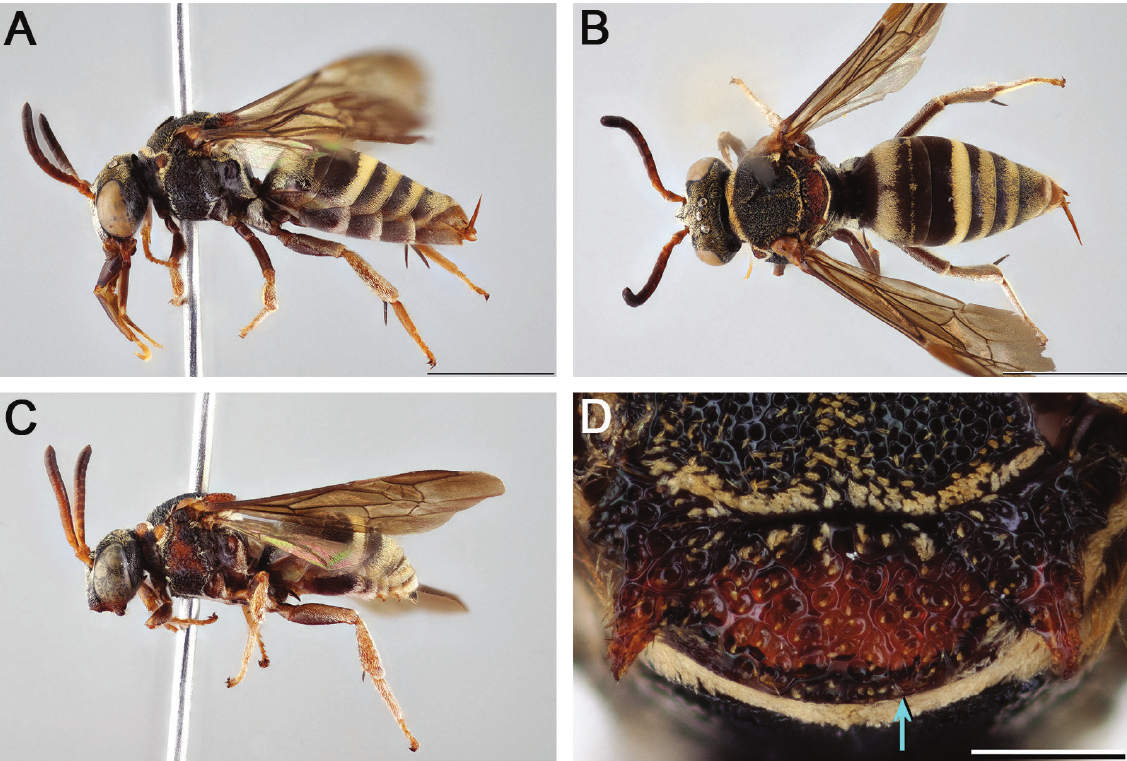
Fig. 10. Epeolus fulvopilosus Cameron, 1902. A . Female, habitus, lateral view. B . Female, habitus, dorsal view. C . Male, habitus, lateral view. D . Female axillae and mesoscutellum, dorsal view (blue arrow indicates one of two posteriorly directed tooth-like projections of mesoscutellum). Scale bars: A–C = 3 mm; D = 0.5